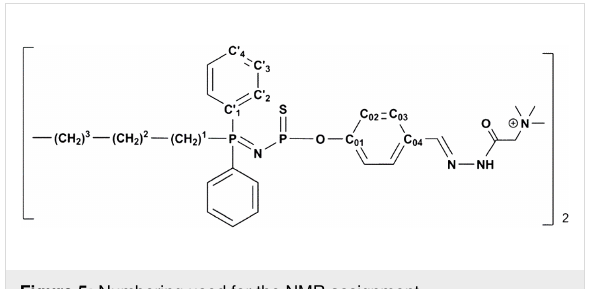
Figure 5: Numbering used for the NMR assignment.